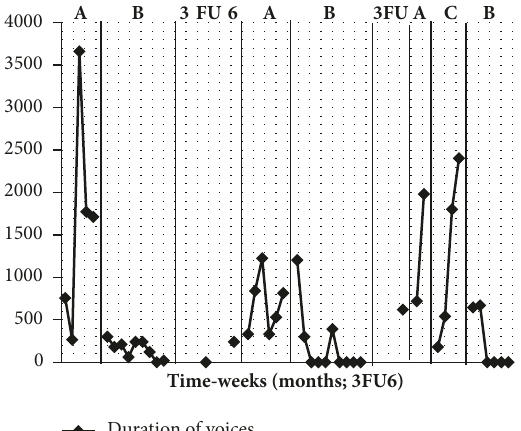
Figure 2: Durationof voices (y-axis = total minutesper week; x-axis = weekly sessions with periods of follow-up (FU) measured at 3 and 6 months after each B phase. Note: A = baseline, B = ATT, and C =